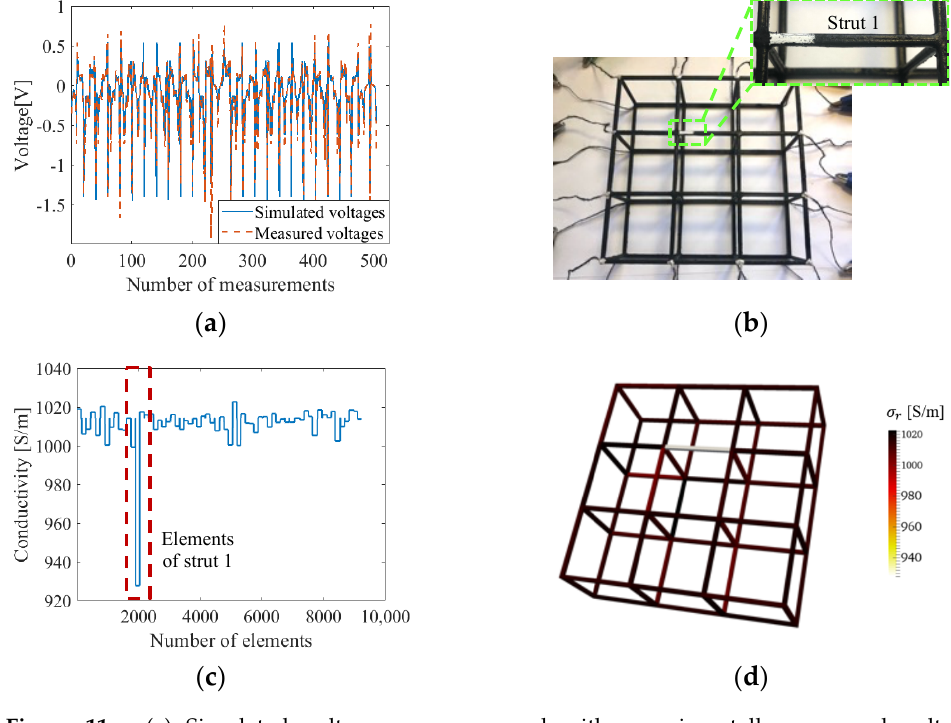
Figure 11. ( a ) Simulated voltages are compared with experimentally measured voltages. ( b ) The first etch (damage) was introduced in the lattice. ( c ) The reconstructed conductivity values of each element when solved with the normalized sensitivity map are plotted. ( d ) The corresponding 3D conductivity distribution successfully confirmed damage detection in strut 1. Table 5. Image errors comparison of single-defect reconstructions in Table 5. Image errors comparison of single-defect reconstructions in experiment. Strut-Based Evaluation Without normalized sensitivity map With normalized sensitivity map